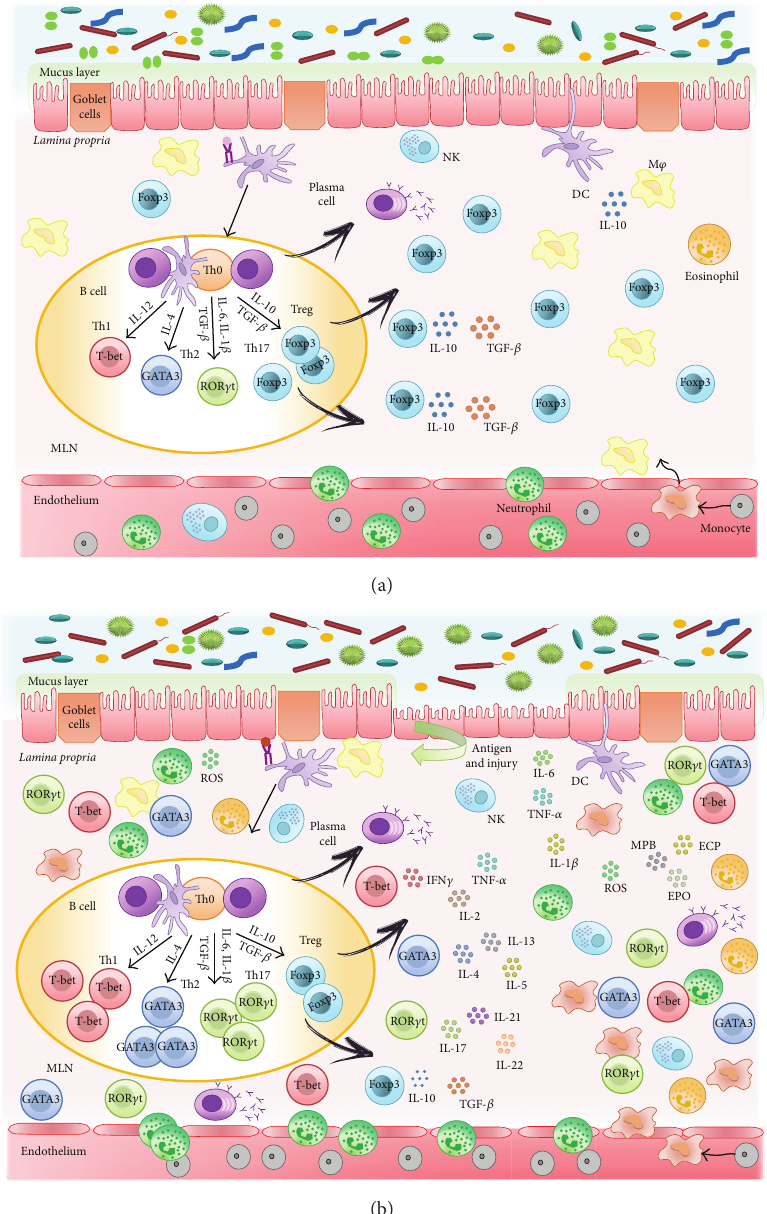
Figure 1: Physiopathology of IBD. (a) The intestine is the largest mucosal surface exposed to the external environment. It constitutes an interface between the host and the luminal contents, which include nutrients and the highest count of resident microbes. Thus, the intestinal immune system meets more antigens than any other part of the body and it must discriminate between invasive organisms and harmless antigens, such as food, proteins, and commensal bacteria, to prevent infections or preserve the homeostasis. This intestinal homeostasis depends on the dynamic interaction between the microbiota, the intestinal epithelial cells, and the resident immune cells, which coordinate a response that keeps the balance between immunity and tolerance. (b) A breakdown of this balance triggers the chronic inflammatory process that characterizes inflammatory bowel disease. There are often several preexisting conditions that lead to the disease: first of all, a genetic susceptibility of the intestinal immune system to distinguish an environmental antigen presented within the gastrointestinal tract; secondly, the contact with the antigen; finally, usually due to an alteration of the permeability, the antigen is presented to the gastrointestinal mucosal immune system through its paracellular passage, which triggers the inflammatory cascade. During early inflammation, luminal antigens activate the different innate immune cells located in the intestine, including natural killer cells, mast cells, neutrophils, macrophages, and dendritic cells, and maintained inflammatory reaction promotes the activation of the adaptive immune response. Abnormally activated effector CD4+ T helper (Th) cells synthesize and release different inflammatory mediators that generate an amplified inflammation that originates from chronic tissue injury and epithelial